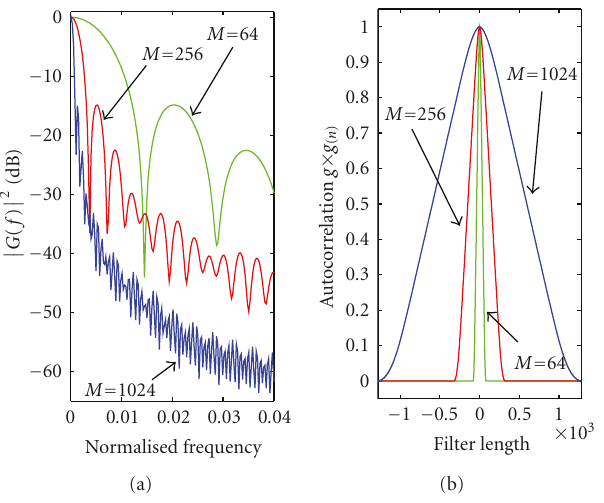
Figure 12: Frequency response and pulse autocorrelation for parameters M 0 = 8, N 0 = 9, and L f = N